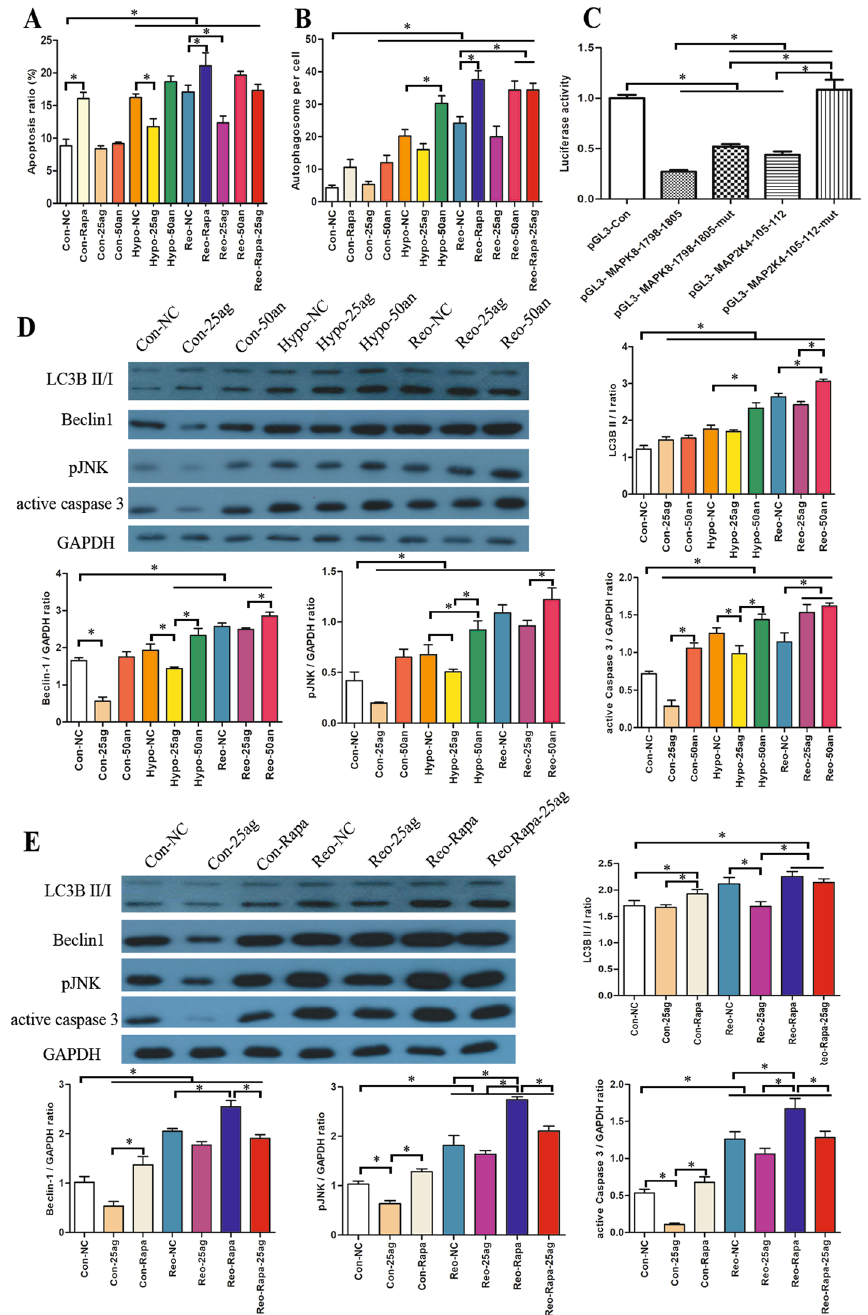
Fig. 3 Regulation of autophagy and apoptosis in HK-2 cells by miR-92a.The apoptotic rate A and the number of autophagosomes B of HK-2 cells in each group were compared. C Luciferase reporter assay found that miR-92a agomir targeted 3 ′ -UTR of MEK and JNK. Representative band and statistical analysis of regulating miR-92a on the protein expression D of hypoxia and reoxygenation groups and the protein expression E of Rapa-treated groups. * P < 0.05. Con control, GAPDH glyceraldehyde phosphate dehydrogenase, Hypo hypoxia, LC3B microtubule-associated protein 1 light chain 3B, NC negative control, pJNK phosphorylated c-Jun NH (2) terminal kinase, Rapa rapamycin, Reo reoxygenation, 25ag 25 nM miR-92a agomir, 50an 50 nM miR-92a